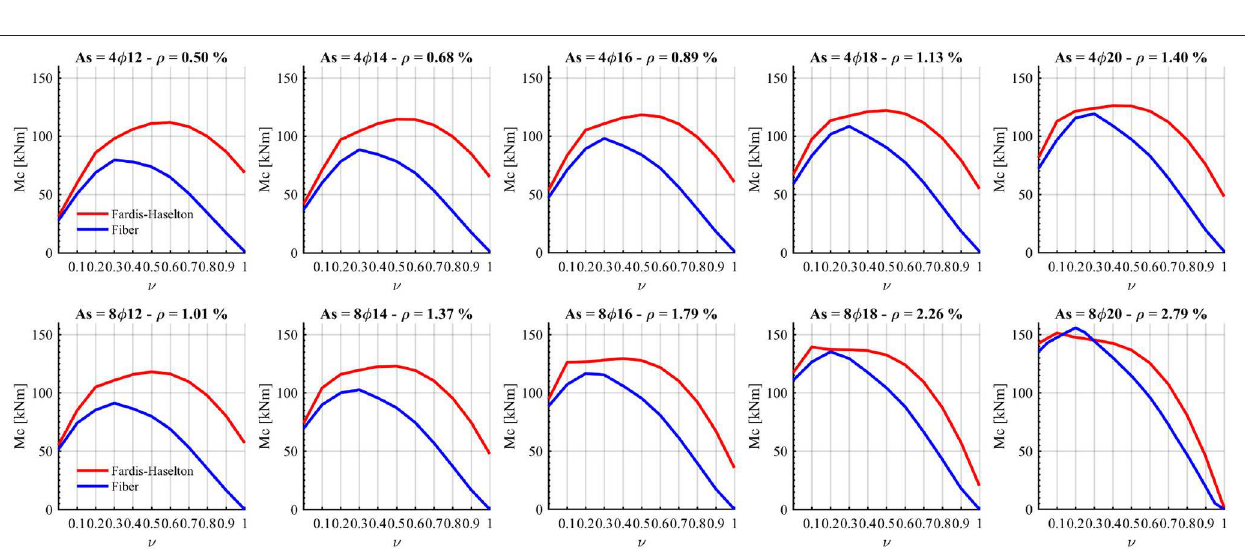
FIGURE 5 | Reinforced concrete column ultimate moments obtained with Haselton et al. (2008) predictive equation and with a fiber section for different reinforcement ratios.